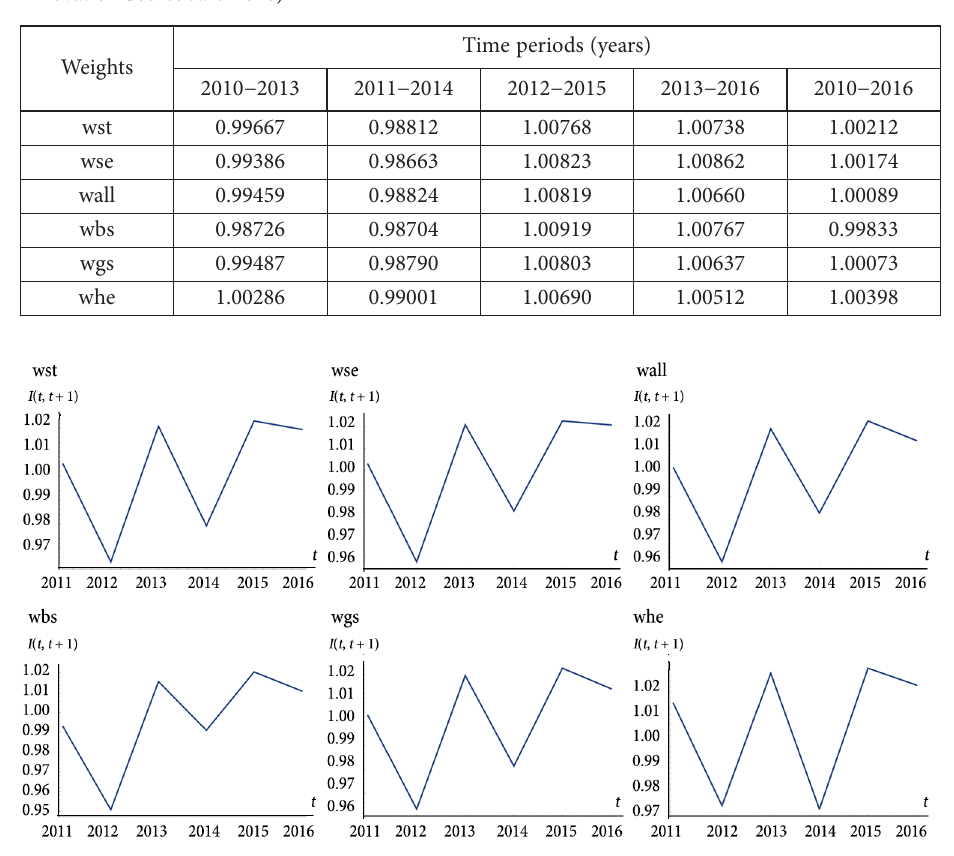
Table 7. The average innovativeness change ( , ) I s t calculated for the V-4 (source: own elaboration based on the data of the European Statistical Office – Eurostat and European Commission, 2018. European Innovation Scoreboard 2018)